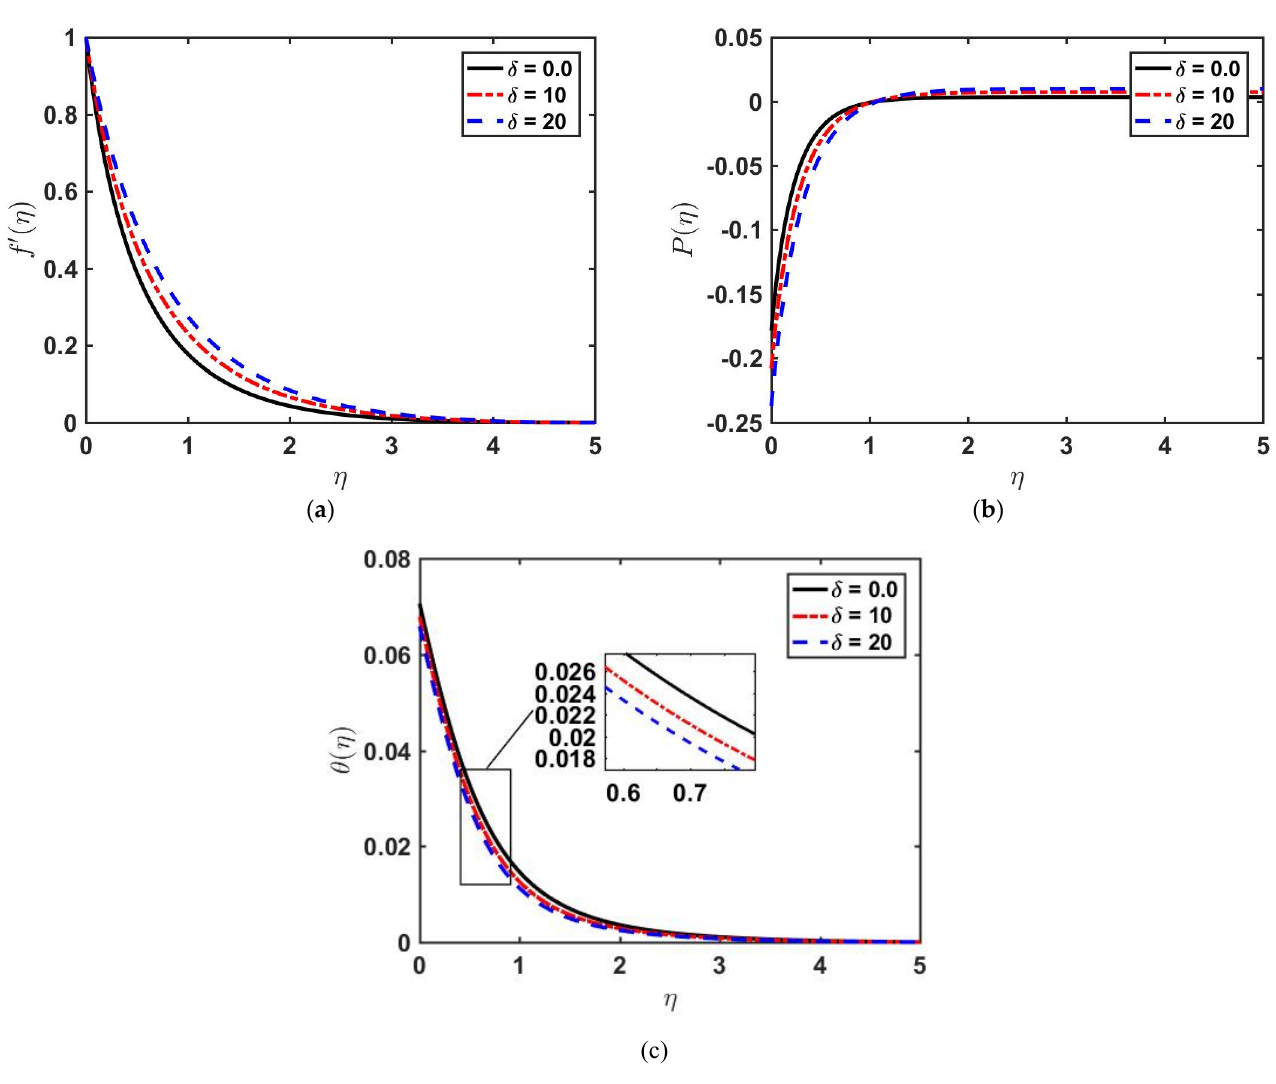
Figure 14. Effect of 𝜹 on ( a ) 𝒇′(𝜼) , ( b ) 𝑷(𝜼) , and ( c ) 𝜽(𝜼) .